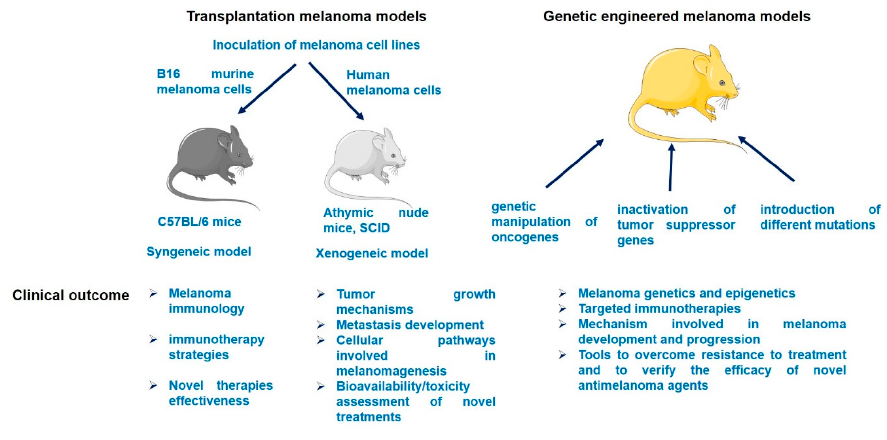
Figure 1. A schematic overview of murine melanoma models and their clinical